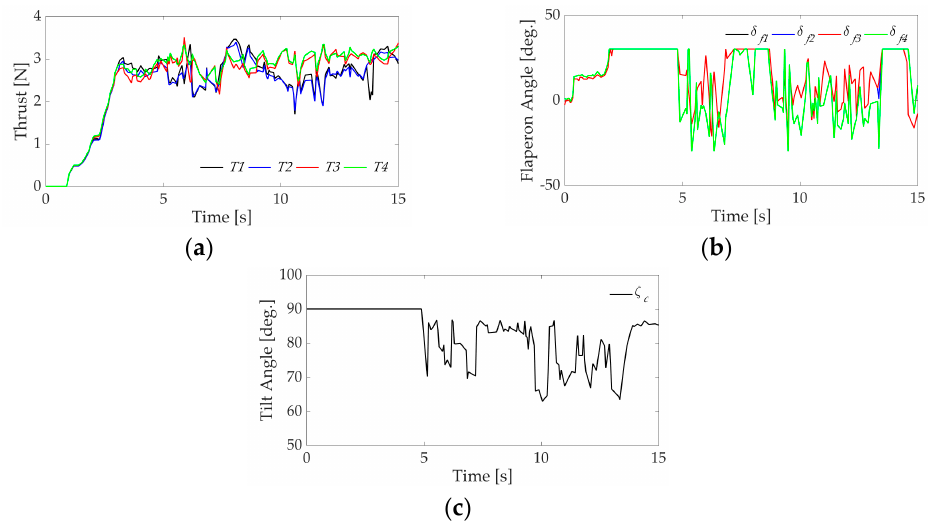
Figure 17. Experimental result of ( a ) position, ( b ) attitude and ( c ) angular velocity using proposed controller.